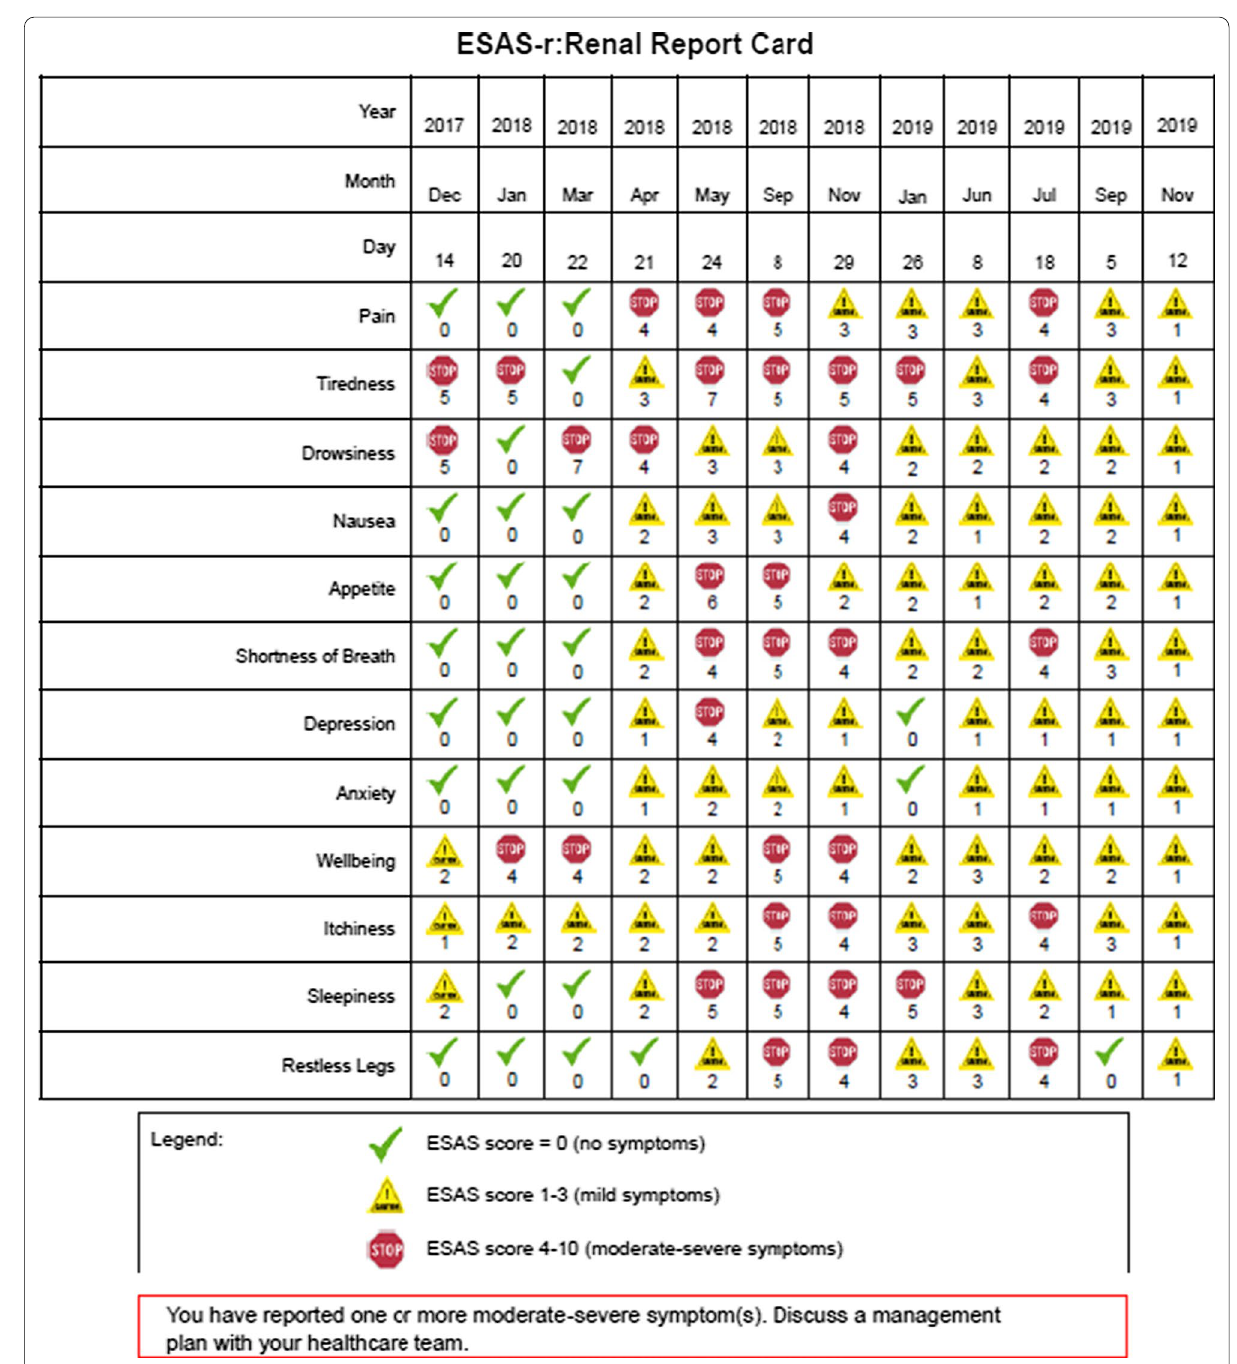
Fig. 1 Sample ESAS‑r: Renal PROMs report